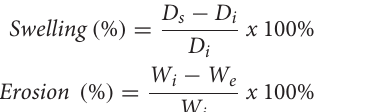
conical flask and placed in an incubator shaker (100 rpm) at 37 ◦ C. The beads were removed from the medium at specific